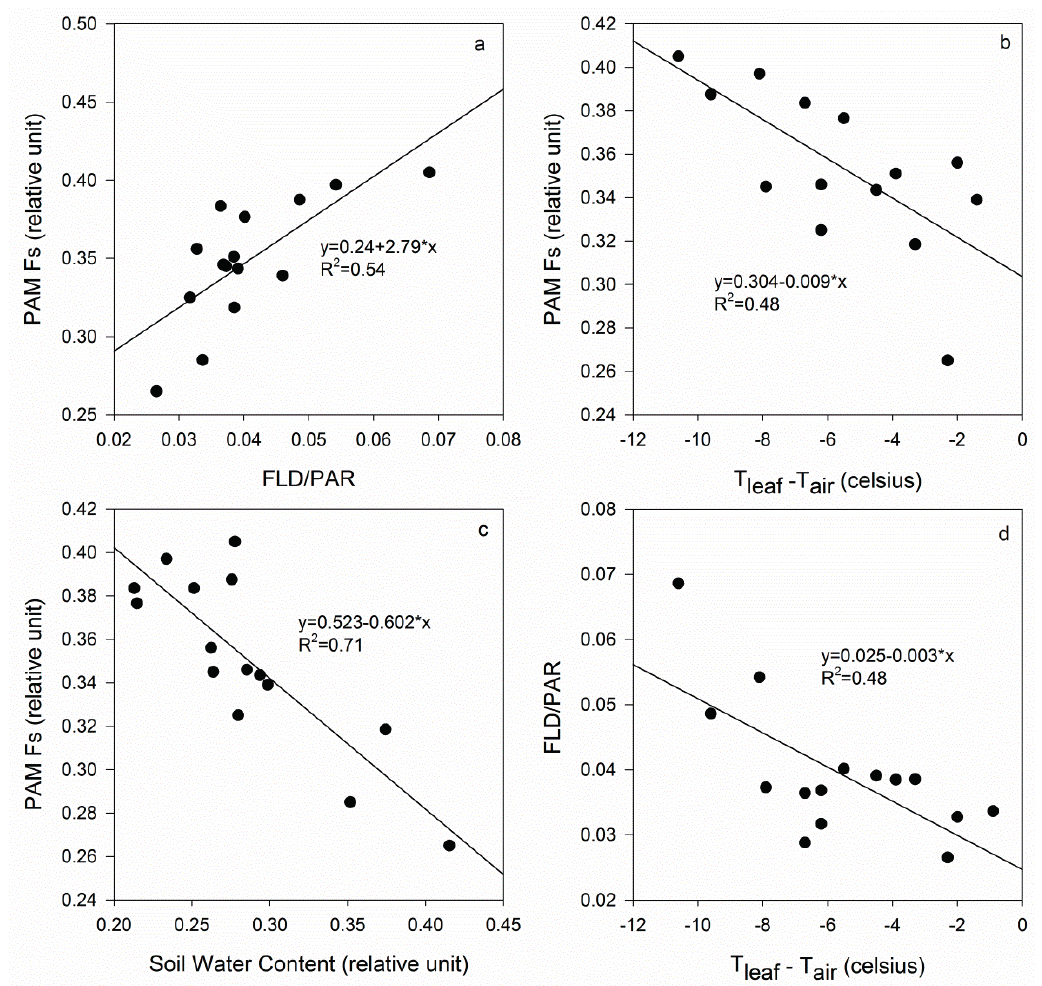
Figure 7. Comparison of the active and passive measurements ( a ) PAM Fs vs. FLD/PAR; ( b ) PAM Fs vs. T leaf -T air ; ( c ) PAM Fs vs. Soil water content; and ( d ) FLD/PAR vs. T leaf -T air